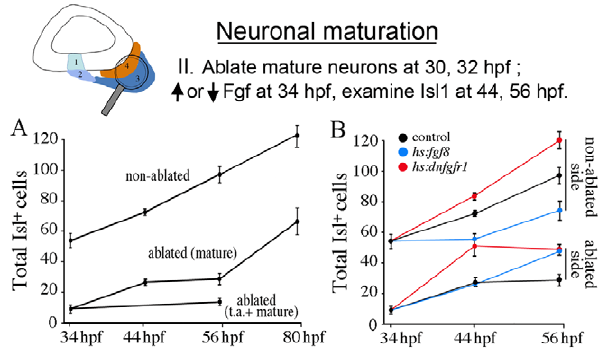
Figure 9. Regeneration following SAG ablation. The icon at the top of the figure indicates that neuronal maturation is the focus of analysis. Manipulations in these experiments (Neuronal maturation group II) are briefly summarized at the top. (A) Accumulation of Isl1 + SAG neurons in isl2b:Gfp/ + embryos after serial ablation of Gfp-positive neurons (mature) or ablation of Gfp-positive neurons and transit- amplifying cells (t.a. + mature) at 30 hpf and 32 hpf. Neuronal accumulation on the contralateral (non-ablated) side served as a control. (B) Effects of modulating Fgf after serial ablations at 30 hpf and 32 hpf on the total number of Isl1 + neurons. Embryos were heat shocked for 30 minutes at 39 u C ( + / + and hs:fgf8/ + embryos) or 38 u C ( hs:dnfgfr1/ + embryos) beginning at 34 hpf. Data show means and standard deviations of 2–5 specimens per time point.